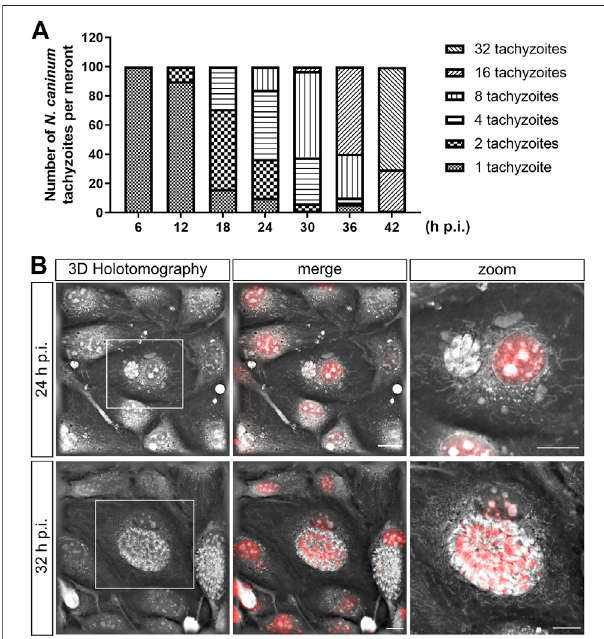
FIGURE 1 | N. caninum tachyzoite intracellular development in primary bovine umbilical vein endothelial cells (BUVEC). Sub-con fl uent BUVEC were infected with N. caninum tachyzoites at an MOI 3:1 and analyzed from 6 to 42 hp.i. (A) Fixedcellswerestainedagainst N.caninum tachyzoite,and thetachyzoitenumbers/parasitophorousvacuole(PV)werecountedevery6 h during 42 h of infection. Mature tachyzoites were observed between 36 and 42 h p. i. The graph shows the distribution of the number of tachyzoites per meront at each time point. In BUVEC, the fi rst duplication of N. caninum tachyzoites was observed only after 6 h p. i. Cells were lysed after 42 h p. i, thereby releasing newly formed tachyzoites into the medium. (B) Live cell 3D- holotomography images of N. caninum tachyzoite-infected BUVEC at 24 and 32 h p. i. nuclei of both, i. e., BUVEC and parasites, were stained with DRAQ5 (vital DNA staining, red). Bars: 5 μ